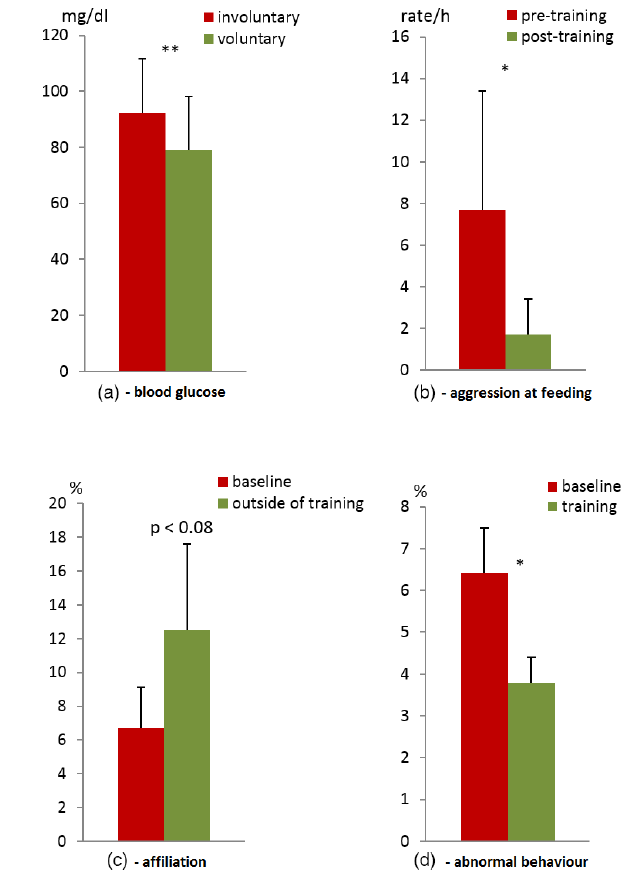
Figure 3. (a) Mean ( + SD) blood glucose (GLU) levels (mgdL − 1 ) in 79 chimpanzees presenting a thigh either voluntarily or involun- tarily for an anaesthetic injection (dependent data; Lambeth et al., 2006). (b) Mean hourly rate of aggression ( + SE) before and after training during feeding in a group of eight chimpanzees (Bloom- smith et al., 1994). (c) Mean percent time ( + SD) spent in affiliative interactions for seven low-affiliating rhesus macaques during base- line and outside of training during the training phase (Schapiro et al., 2001). (d) Mean percent time ( + SE) spent in abnormal be- haviour in a group of 12 chimpanzees before and during imple- mentation of a training program (Pomerantz and Terkel,